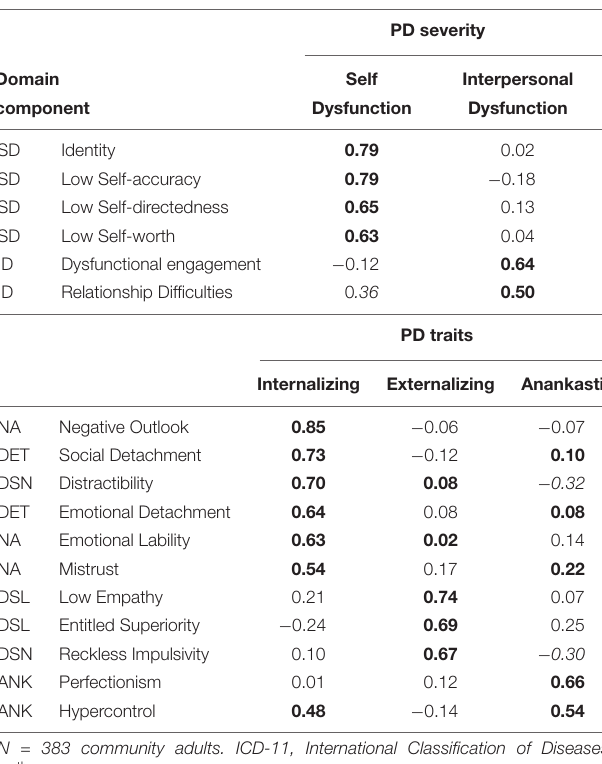
TABLE 6 | Promax-rotated principal axis factor analyses of ICD-11 PD-severity and PD-trait component scales, respectively.